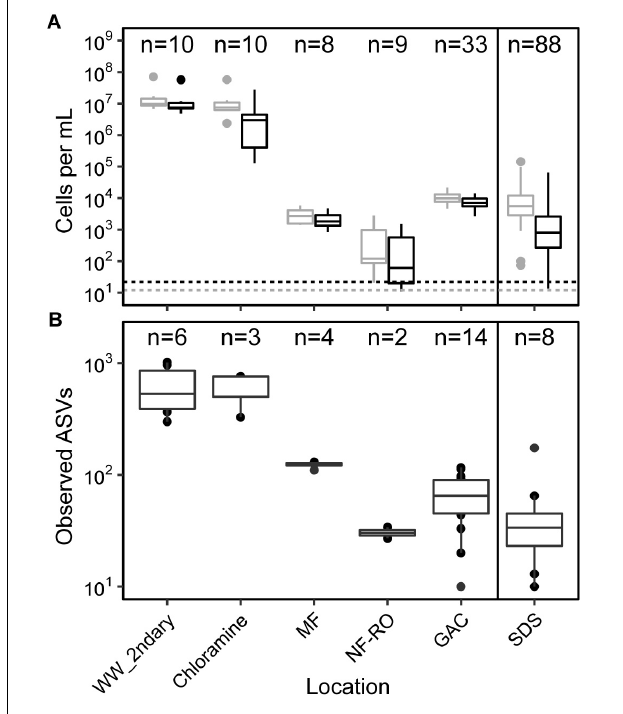
FIGURE 2 | Cell counts and diversity in bulk water across the treatment train. (A) Counts of total (gray) and intact (black) cells based on flow cytometry, and (B) counts of observed amplicon sequence variants (ASVs). Solid line in both panels indicates chlorination and storage prior to feeding into simulated distribution systems (SDS). Dashed lines indicate minimum detection limits for total and intact cell counts (see Supplementary Table S7 for supporting data). Sample numbers for flow cytometry and amplicon sequencing (after data decontamination) are noted for each location. In panel (A) , MF and NF/RO cell counts represent interprocess storage tanks after the respective